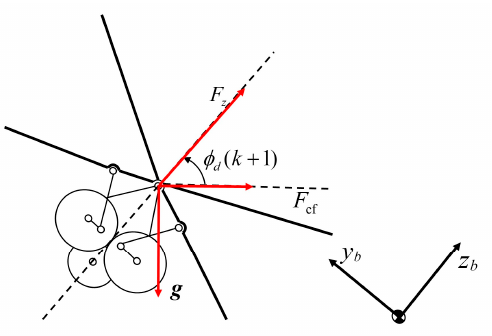
Figure 3. The desired roll angle of CWMAV’s trajectory.